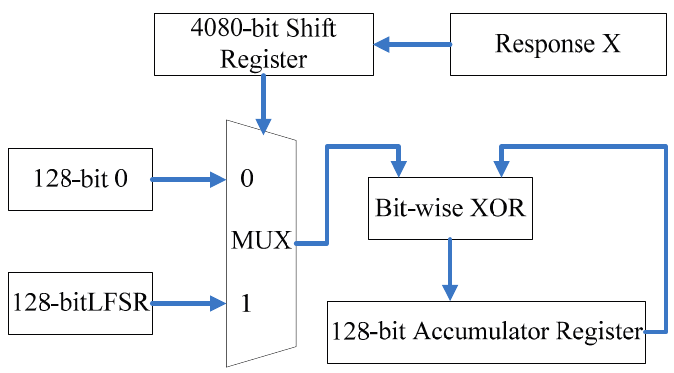
Figure 10. The structure of universal